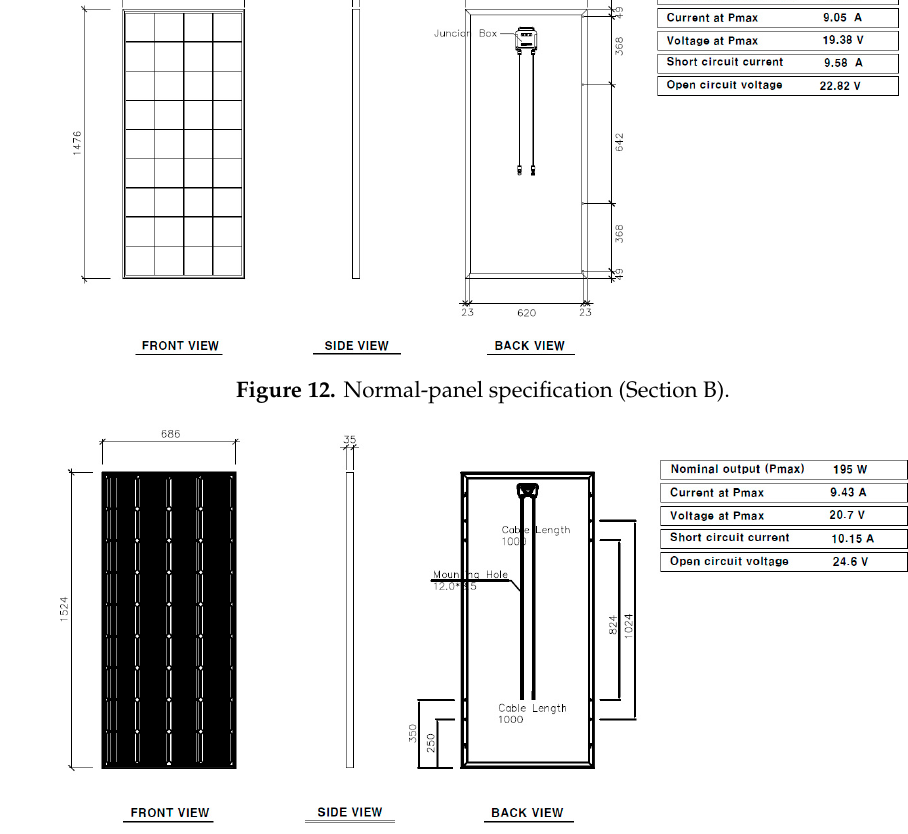
Figure 14. Transparent-panel specification (Section F).